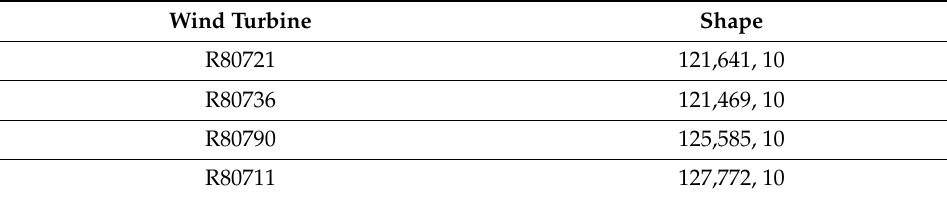
Figure 14. The Pearson Correlation Coefficient Heatmap. Table 9. Shape of Wind Turbine Dataset after Variables Selection by PCC.